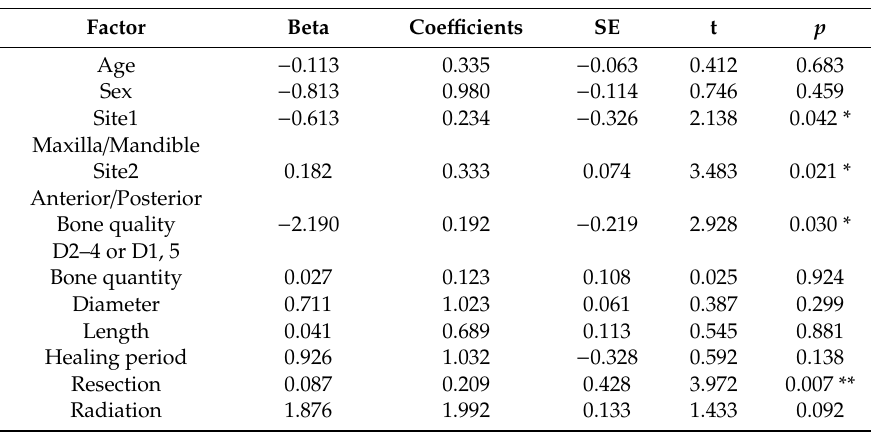
Table 6. Results of the multiple regression